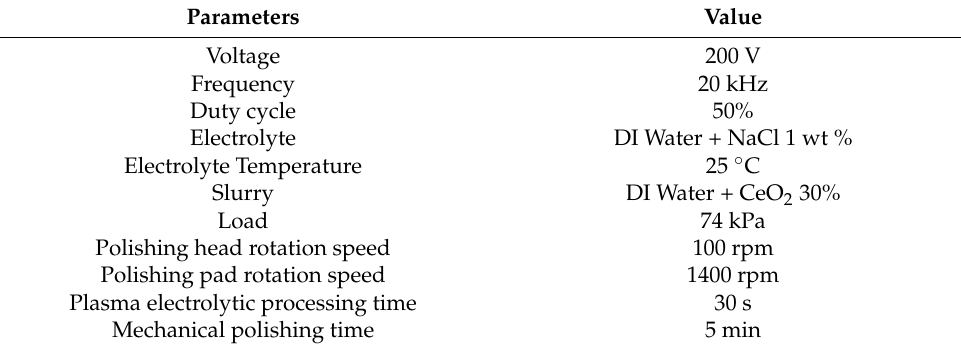
Table 1. Experiment parameters.